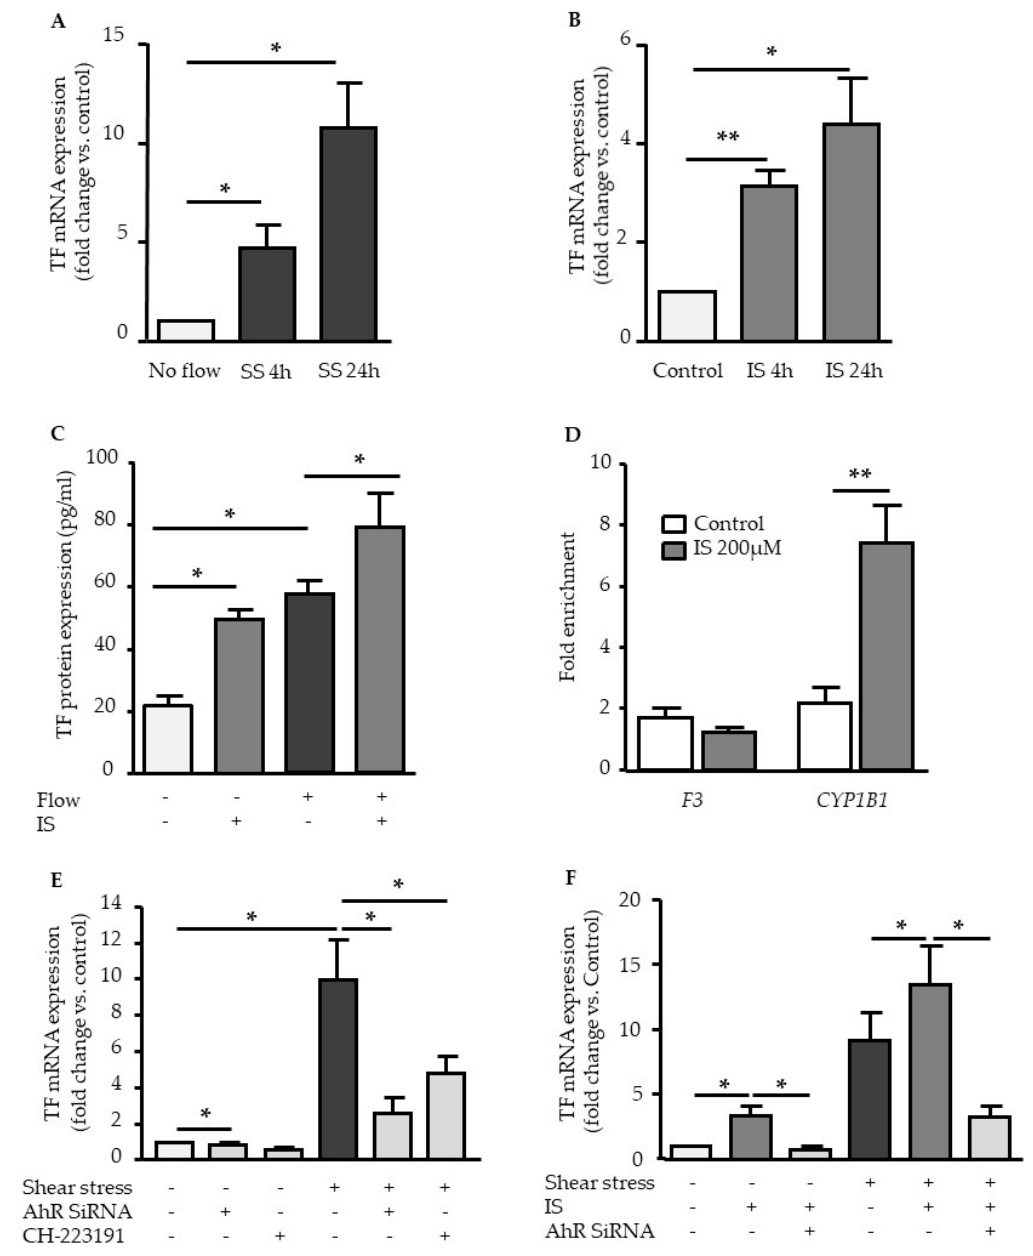
Figure 5. Tissue factor (TF) expression induced by shear stress and IS dependent of AHR activation. E ff ect of shear stress 5 dynes / cm 2 ( A ) and IS 200 µ M ( B ) on TF mRNA expression. Data, expressed as fold change vs. control, represent the mean ± SEM of n = 6 (A) and n = 4 (B) independent experiments. ( C ) E ff ect of shear stress and IS on TF protein expression after 6h of stimulation. Data, expressed in pg / mL, represent the mean ± SEM of n = 6 independent experiments. ( D ) AHR binding to the promoters of F3 and CYP1B1 was studied by chromatin immunoprecipitation (ChIP) after 1 h of human umbilical vein endothelial cells (HUVEC) stimulation by 200 µ M IS. Data, expressed as fold enrichment, represent the mean ± SEM of n = 6 independent experiments. ( E ) E ff ect of the AHR inhibitor CH-223191 (10 µ M) and of AHR siRNA on TF mRNA expression after 4 h of shear stress. Data represent the mean ± SEM of 5 independent experiments. ( F ) E ff ect of AHR siRNA on TF mRNA expression after a 4 h stimulation with 200 µ M IS. Data represent the mean ± SEM of 5 independent experiments. * p < 0.05, ** p < 0.01.